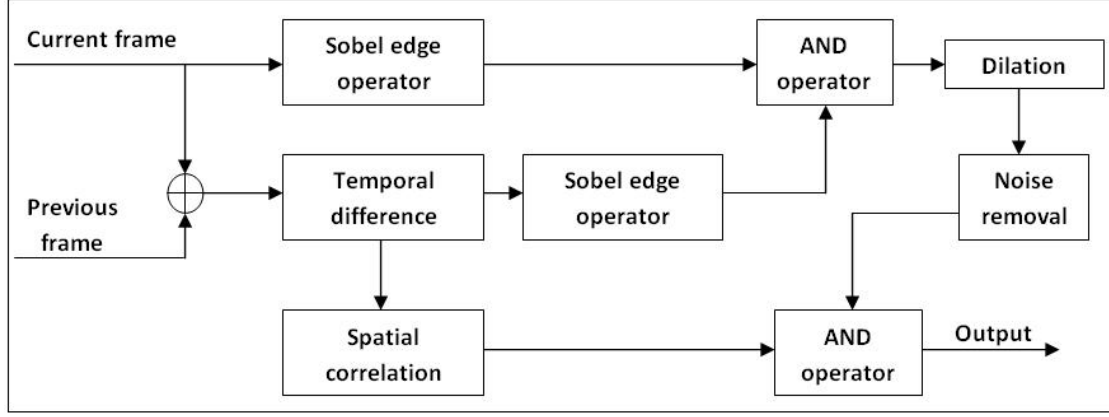
Figure 5. Block diagram of probabilistic edge-based background